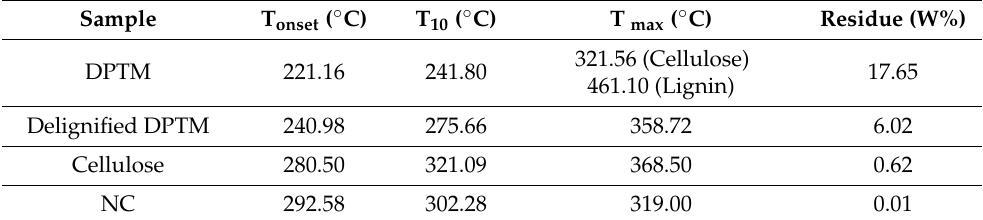
Table 2. Summarized results of TGA analysis of